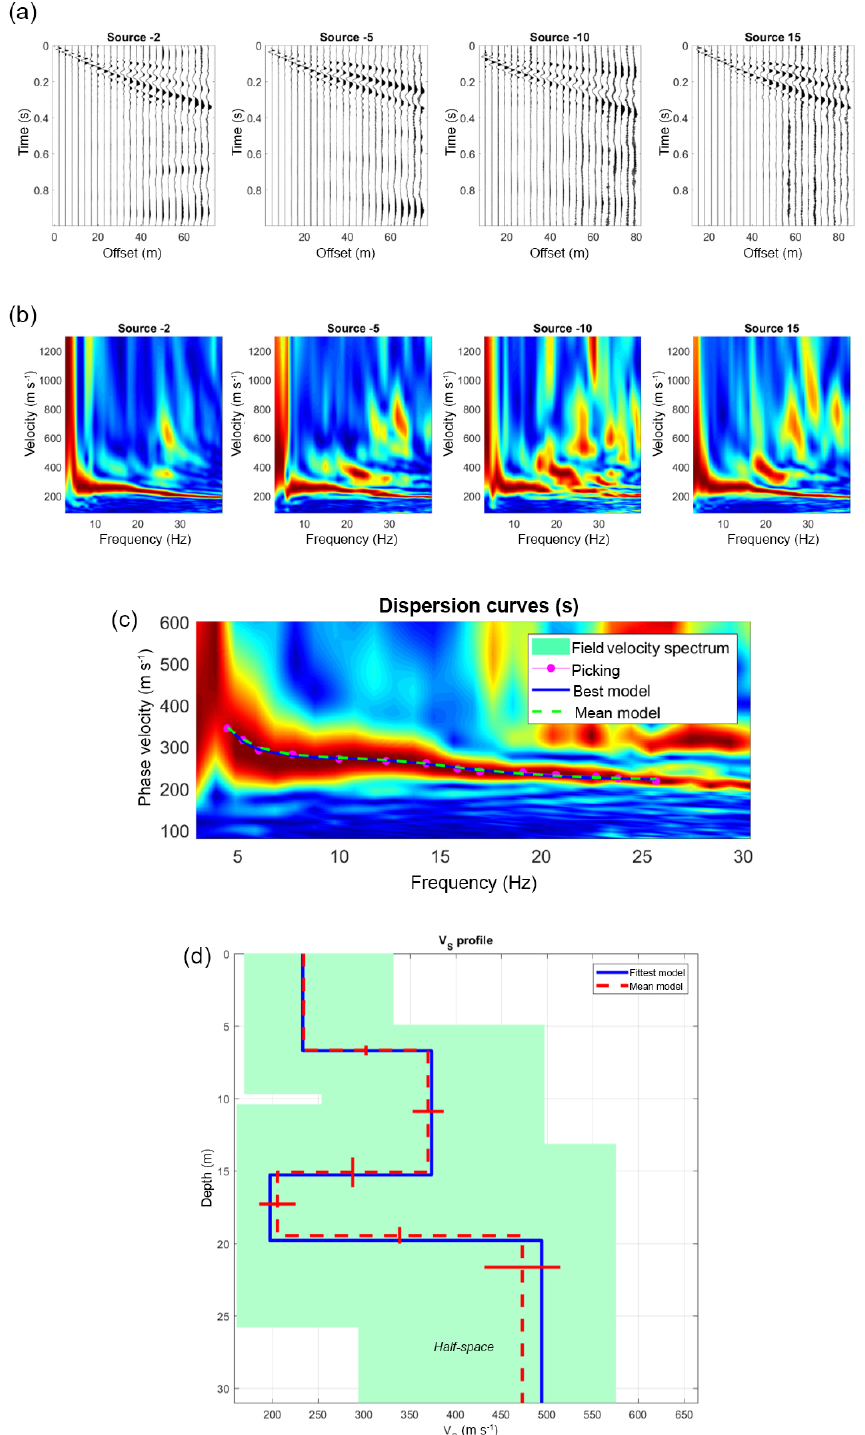
Figure 6. Data processing with WinMASW ® (example from Binyamina): (a) raw data of four different offsets. (b) The four relative dis- persion images calculated from the raw data. (c) Best dispersion image (offset 15): pink dots are the analyst’s dispersion curve picking. The blue line and yellow dashed lines are, respectively, the best and the mean curves from the final model. (d) Shear-wave velocity model (blue profile for the best one and red dashed line is the mean profile from 100 lower